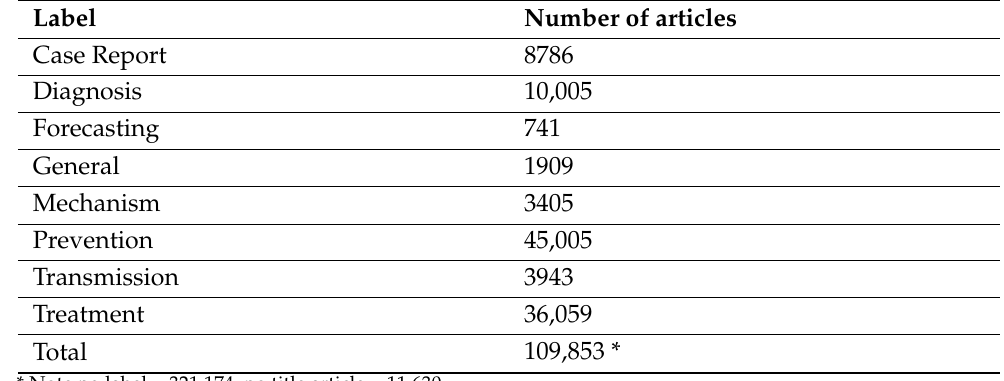
Table 7. Number of articles in Test dataset based on LitCovid database.